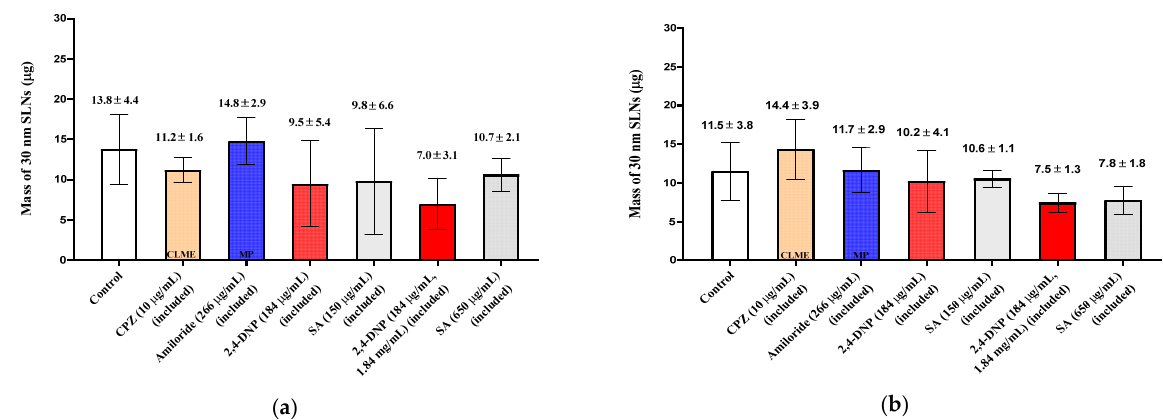
Figure 6. Uptake (30 min) of 30 nm SLNs in the nasal olfactory ( a ) and respiratory ( b ) tissues in the presence of endocytic inhibitors during the 30 min nanoparticle incubation period. Bar graphs display mean nanoparticle uptake ± standard deviation determined from the recovery of Nile Red from the tissues. Statistical comparisons were made between each of the inhibited tissues and the control tissues using Student’s two-tailed t -test ( p < 0.05). No statistically significant differences were found.